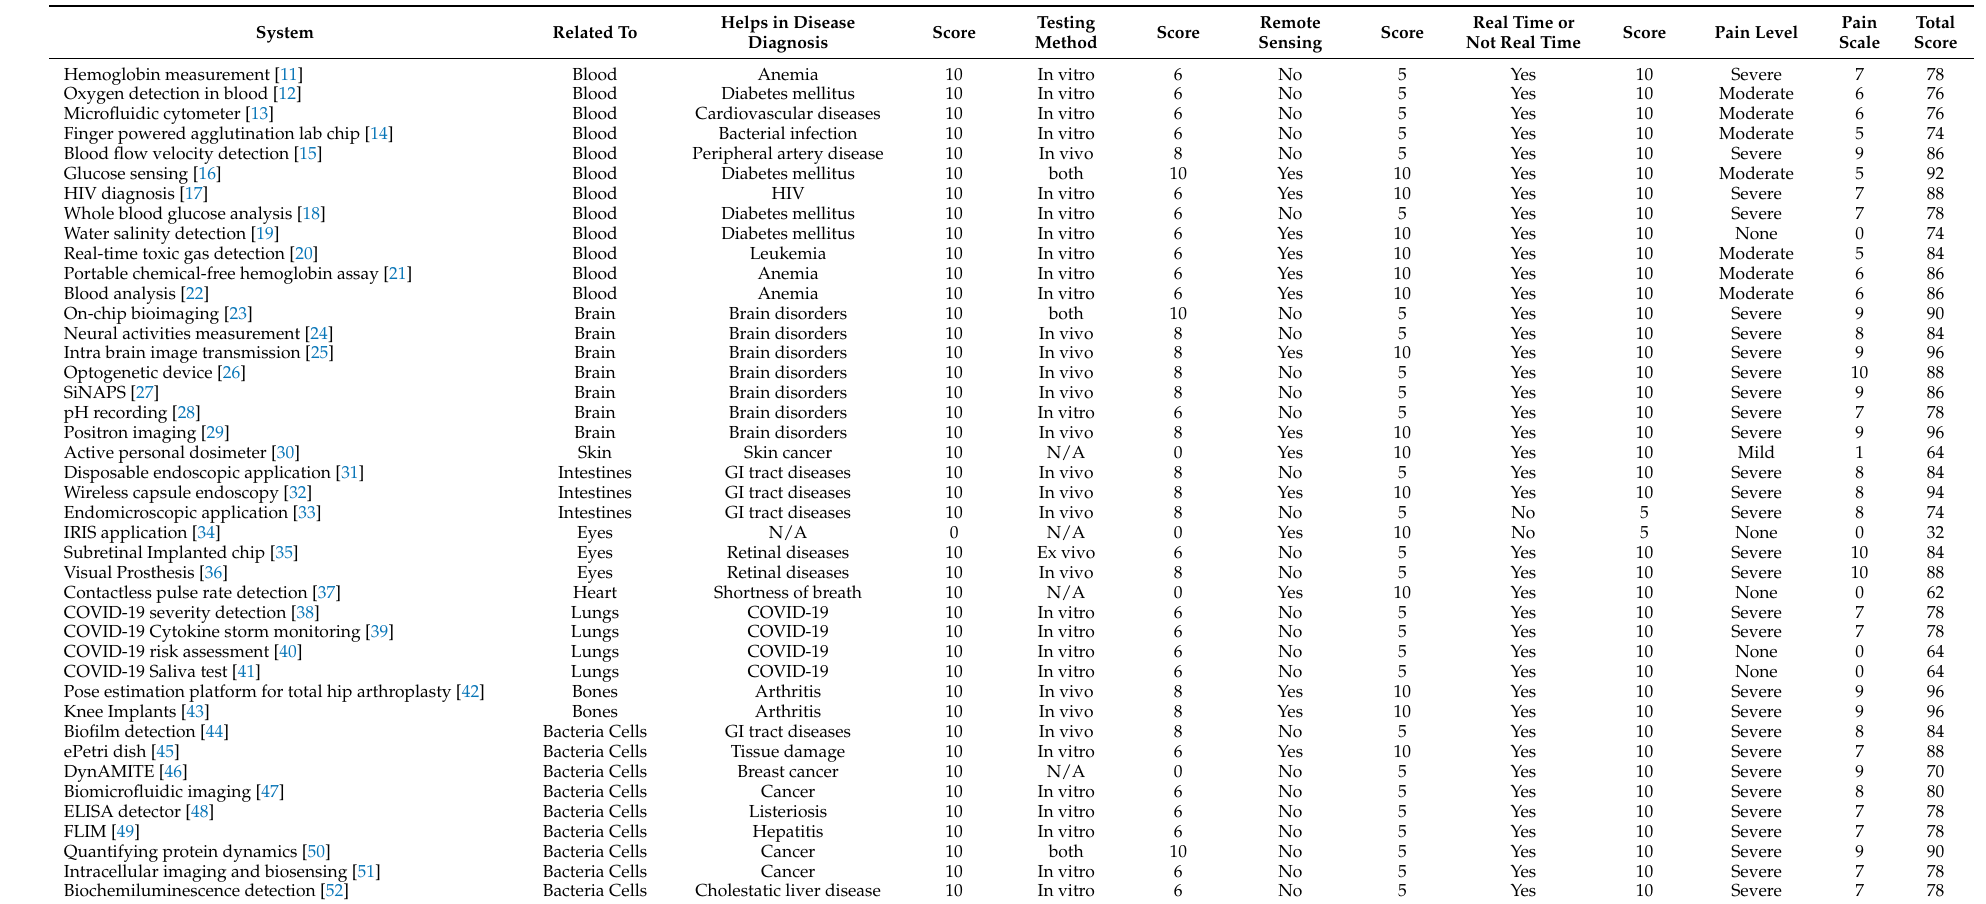
Table 2. Parameter-based system